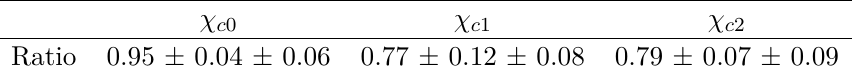
Table 2 . The ratio between the branching fractions of the χ cJ → Ξ − ¯Ξ + and χ cJ → Ξ 0 ¯Ξ 0 processes. The first uncertainty is statistical and the second is systematic. Systematic uncertainties arising from the same source cancel when calculating the